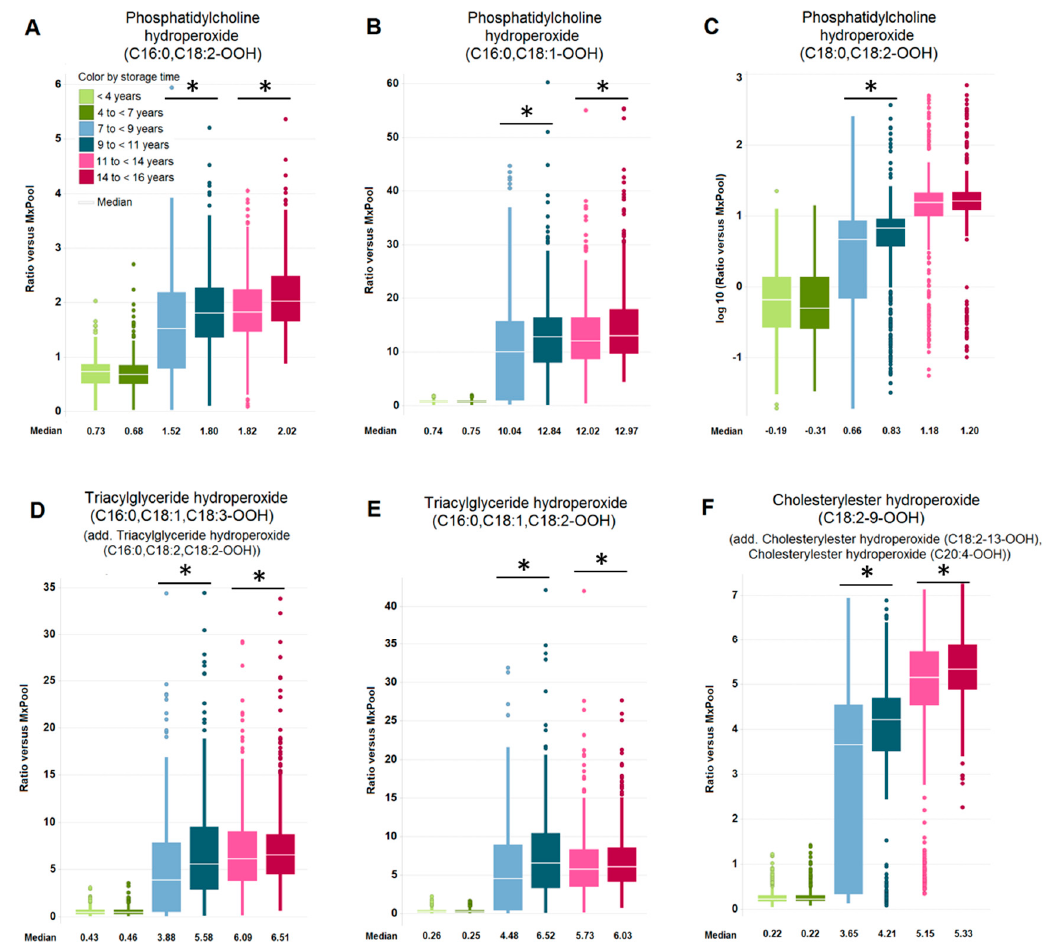
Figure 3. Long-term stability of PC hydroperoxides, TAG hydroperoxides, and CE hydroperoxide during storage at − 80°C, shown by box plots. ( A ) PC hydroperoxide ( C 16:0, C 18:2-OOH), ( B ) PC hydroperoxide ( C 16:0, C 18:1-OOH), ( C ) PC hydroperoxide ( C 18:0, C 18:2-OOH), ( D ) TAG hydroperoxide ( C 16:0, C 18:1, C 18:3-OOH), ( E ) TAG hydroperoxide ( C 16:0, C 18:1, C 18:2-OOH), ( F ) CE hydroperoxide ( C 18:2-9-OOH). Asterisk denotes significant changes ( p < 0.05, FDR < 0.05) within subject age groups. The legend is shown in ( A ). Samples from one subject age group are shown in shades of the same color: 70 years of age = red; 75 years of age = blue; 80 years of age = green. The term "add." (in addition) indicates that quantification could be disturbed by small amounts of the depicted metabolites that have identical analytical characteristics with respect to the quantification method.